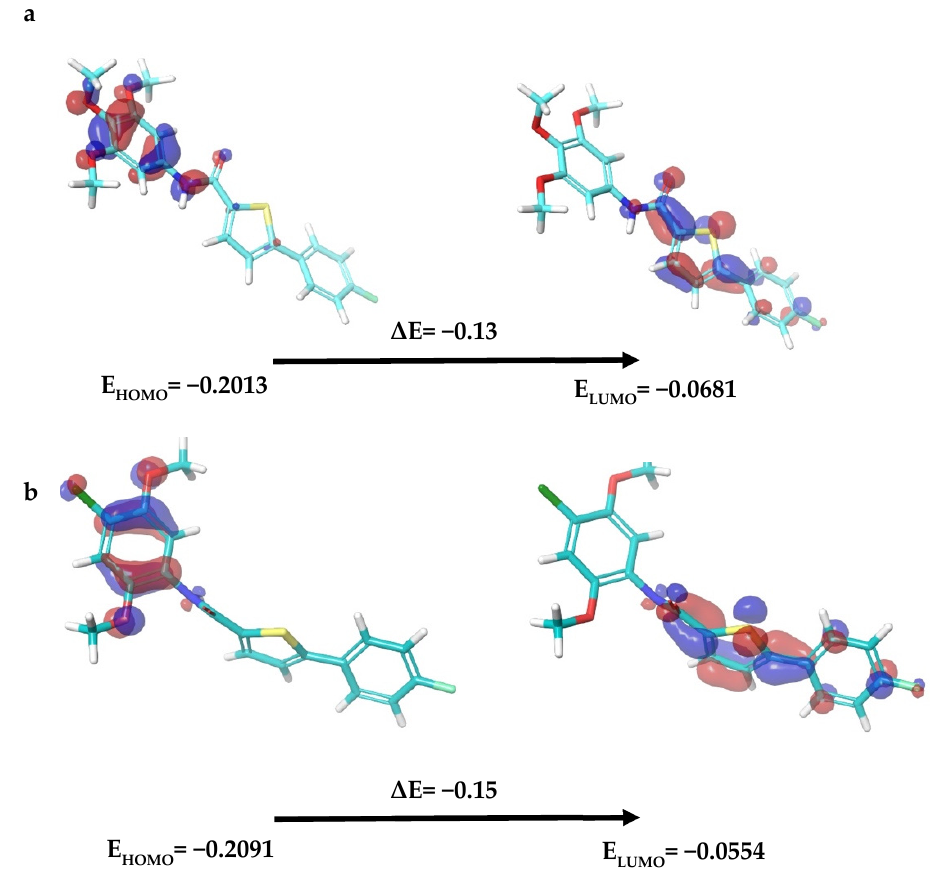
Figure 5. The 3D HOMO and LUMO profiles, the orbital energy values, and the energy gap ( ∆ E) of 2b ( a ) and 2e ( b ) molecules. The red and blue colors refer to positive lobes and negative lobes, re- spectively.